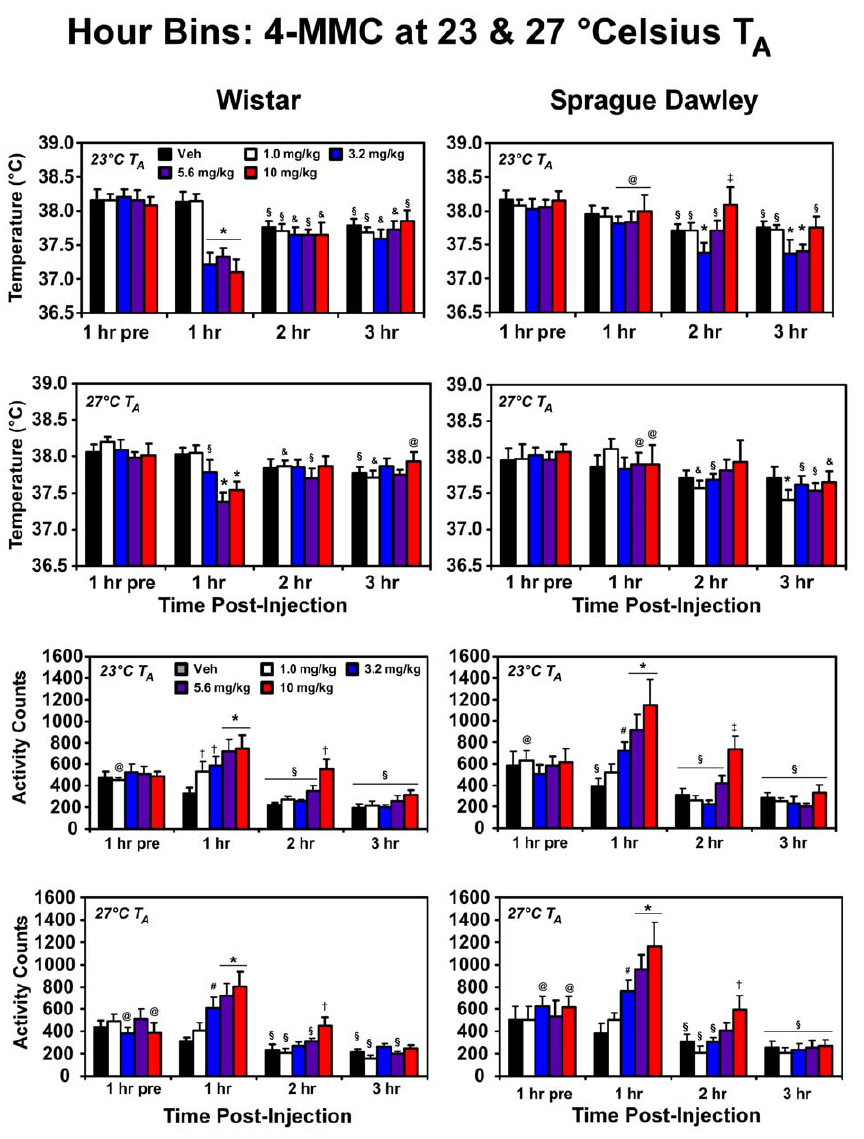
Figure 2. Statistical analysis was conducted on hourly bins (mean temperature and summed activity counts) for three hours after injection. Post-hoc confirmation of a significant difference from the following conditions is indicated by: Vehicle condition at a given timepoint: { ; Pretreatment value within dose condition: 1 ; Pretreatment baseline and vehicle condition at that time point: # ; Vehicle condition, pretreatment value and between strains: *; Pretreatment value and between strains: &; Vehicle condition at the respective timepoint and between strains: { ; Between strains: @.